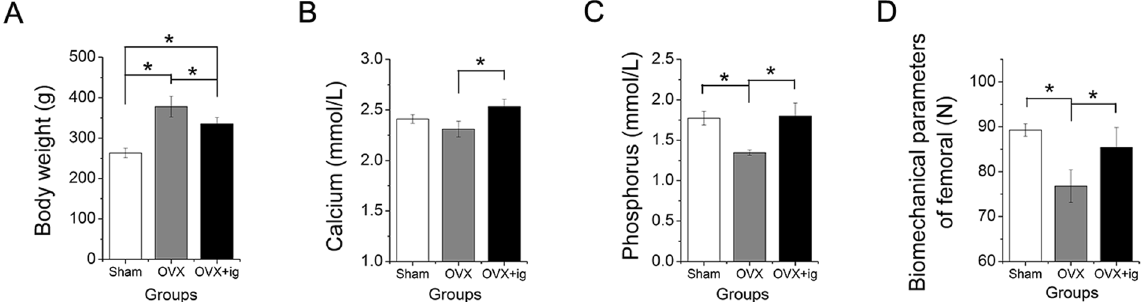
Figure 8. The induced effect of icariin on the weight ( A ), serum calcium ( B ), and serum phosphorus ( C ) content, and femoral biomechanical parameters ( D ) in OVX rats ( * p <